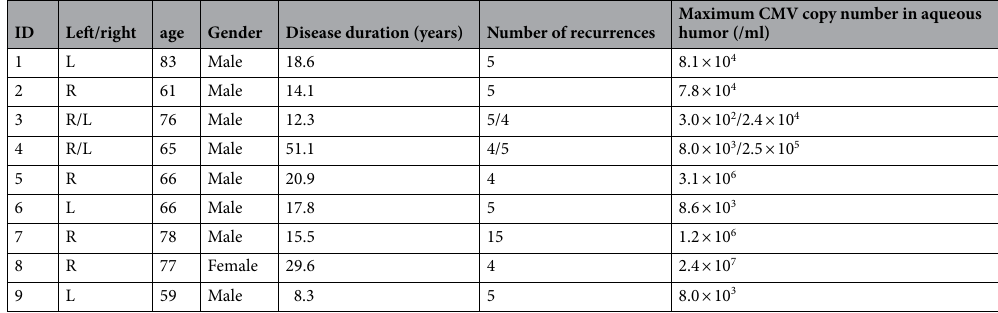
Table 2. Characteristics of CMV corneal endotheliitis patients measured for anti-viral cytotoxic T lymphocyte activity.